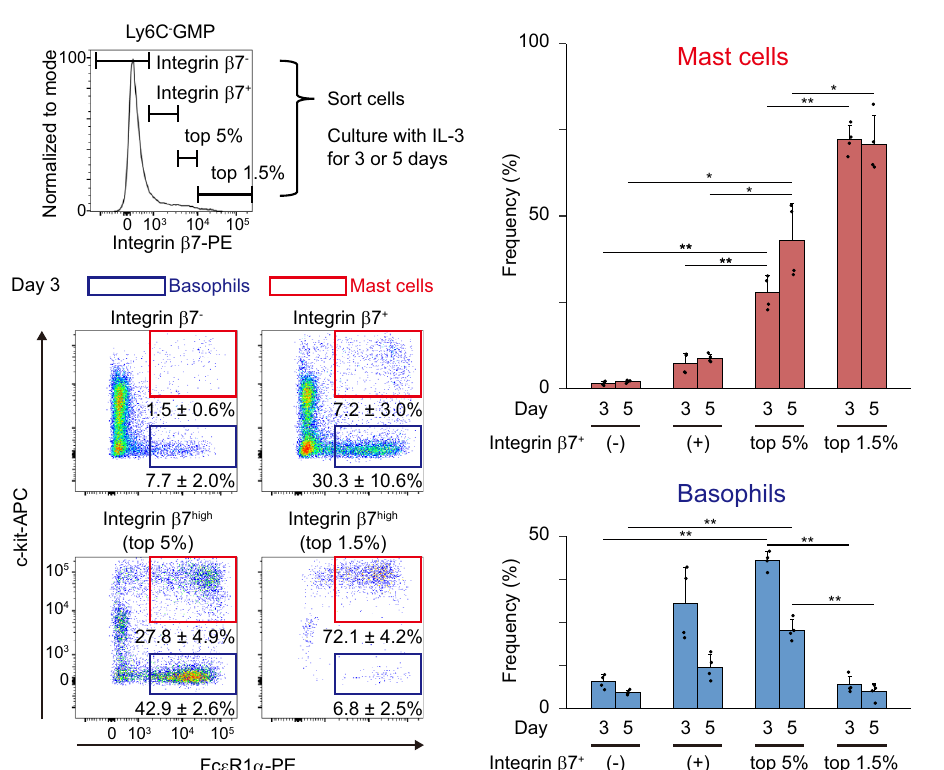
mast cells, de fi ned as Fc ε R1 α + c-kit + (red). The percentages of basophils and mast cells are also shown in the right graph. n =4 from 2 mice and from 2 independent experiments. p =2.4×10 − 6 , 2.8×10 − 5 , 2.4×10 − 6 , and 4.2×10 − 4 for mast cells on day 3, mast cells on day 5, basophils on day 3, and basophils on day 5, respectively, by one-wayWelch ’ sANOVA. * p <0.05and ** p <0.01bytheGames-Howellposthoctest. For mast cells on day 3, p =0.0047, 0.0032, and 4.5×10 − 5 from left to right. For mast cells on day 5, p =0.014, 0.023,and 0.028 from leftto right. Forbasophilson day 3, p =5.2×10 − 6 and 4.4×10 − 6 from left to right. For basophils on day 5, p =0.0029 and 5.2×10 − 4 from left to